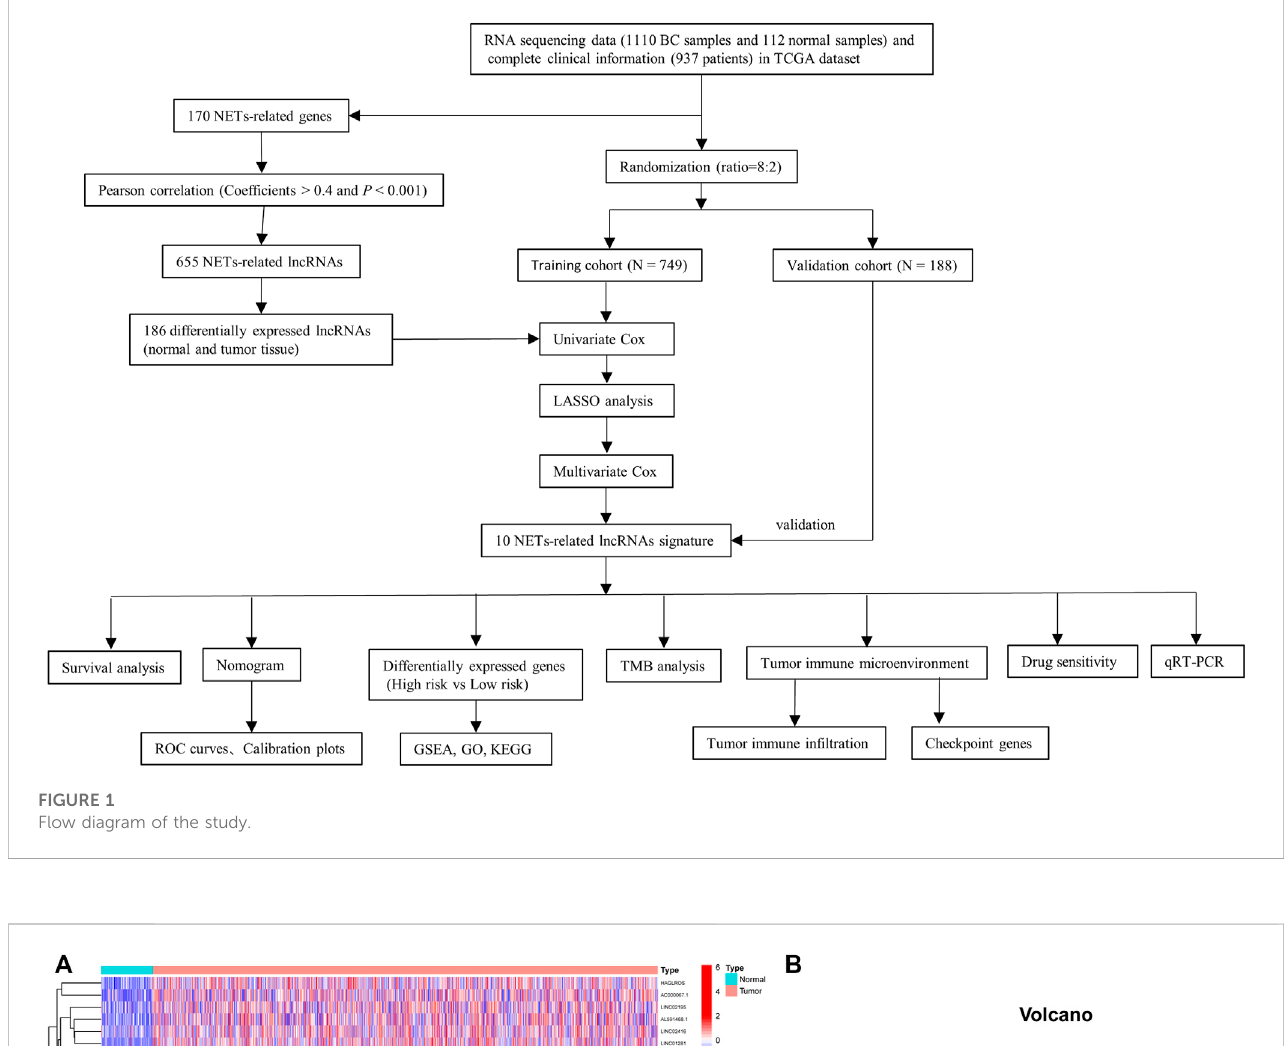
FIGURE 1 Flow diagram of the study.